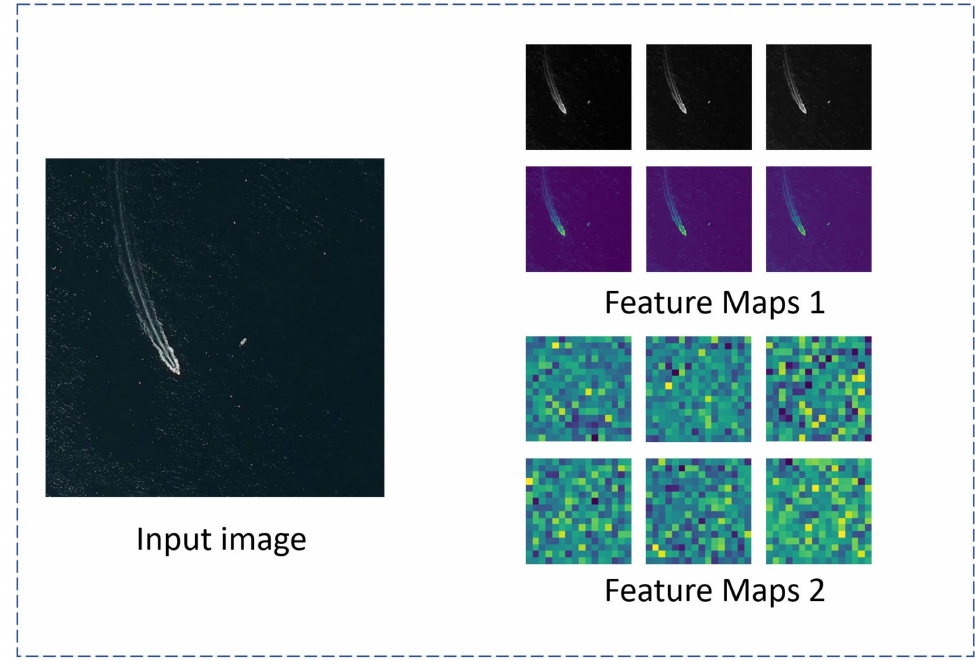
Figure 7. A randomly selected remote sensing image and two sets of feature maps extracted from the embedding